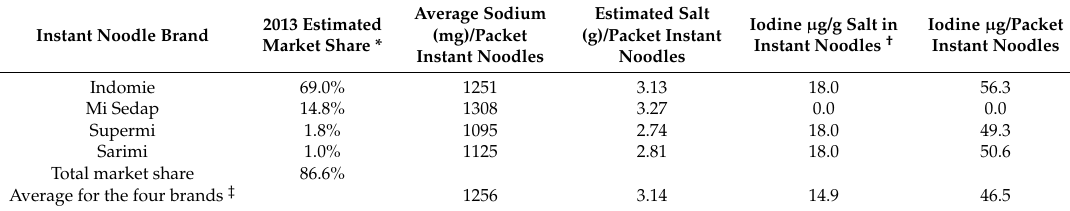
Table 1. Estimated salt and iodine contents of the most popular brands of instant